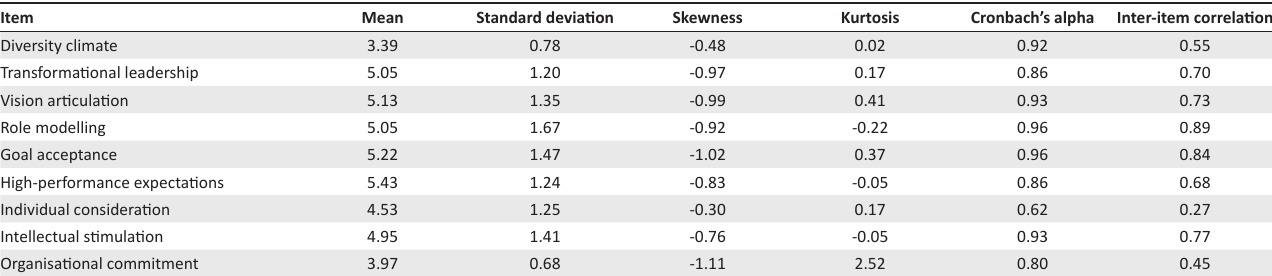
TABLE 2: Descriptive results and